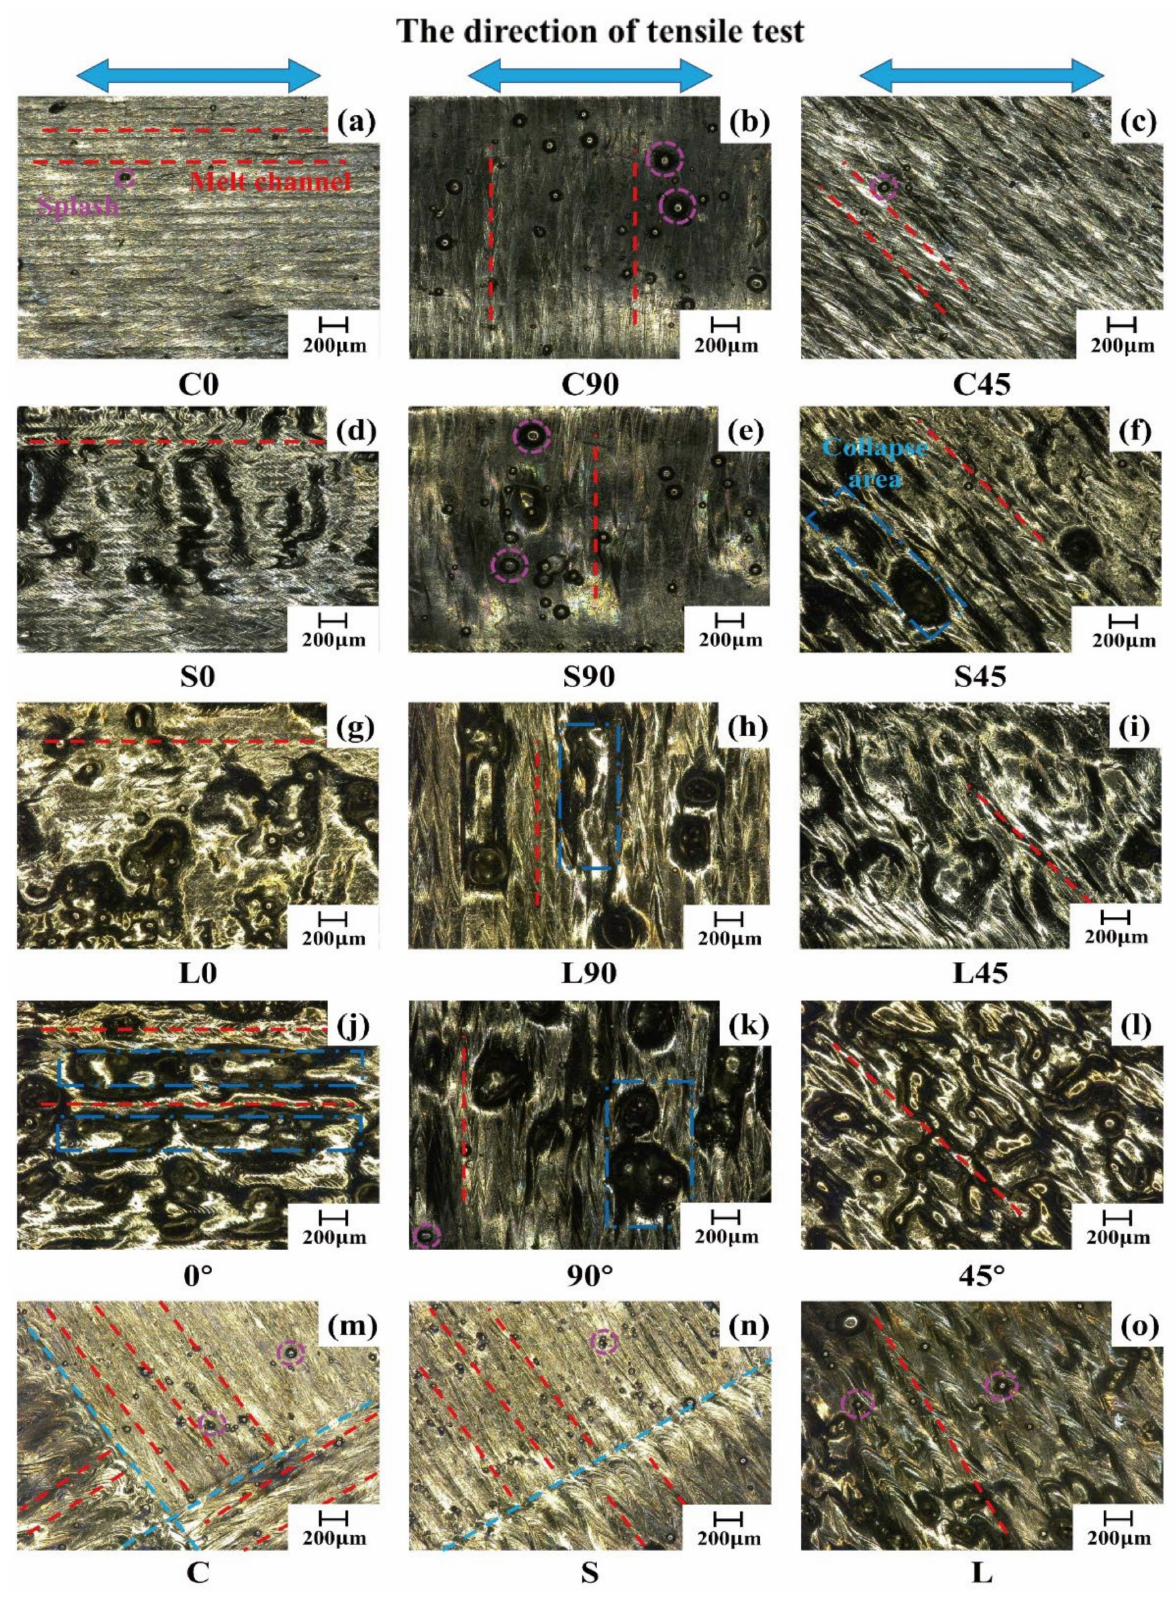
Figure 5. Macroscopic topography of different L-PBF samples. ( a – o ) Corresponding to the surface topography of C0, C90, C45, S0, S90, S45, 0, L90, L45, 0 ◦ , 90 ◦ , 45 ◦ , C, S, and L samples,